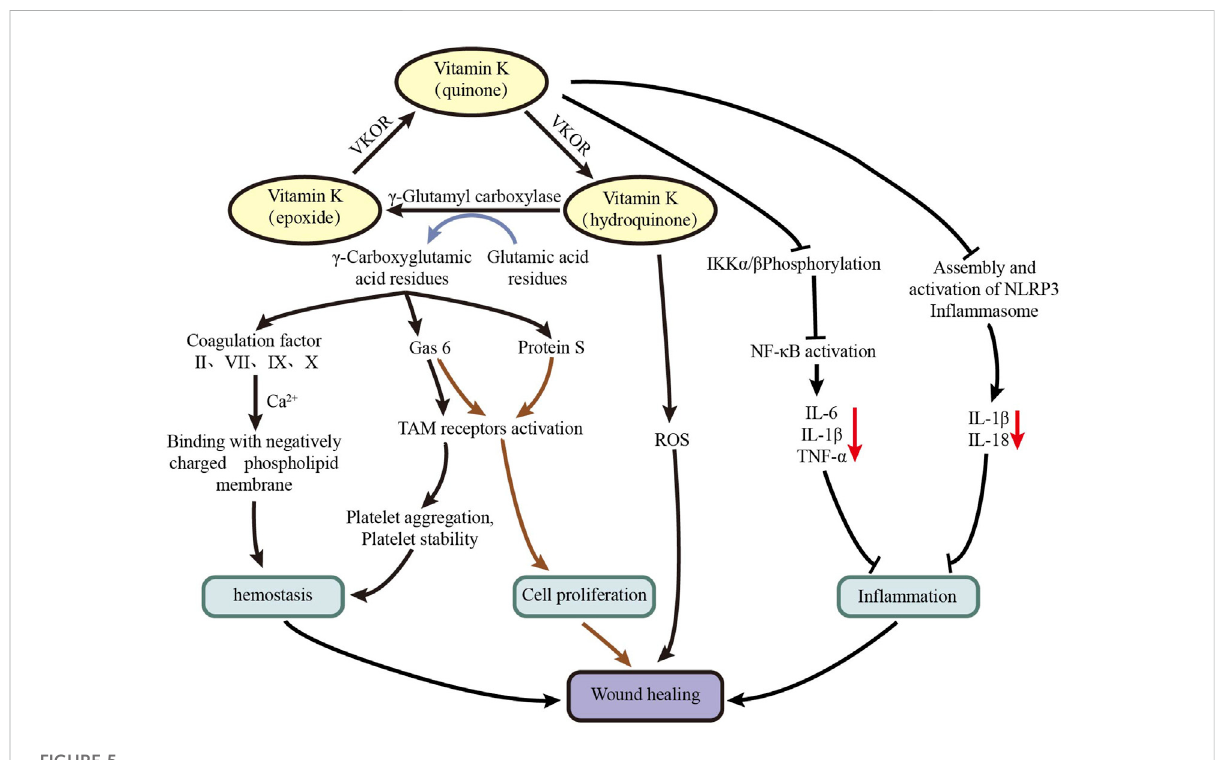
FIGURE 5 Possible mechanism of vitamin K for wound healing.